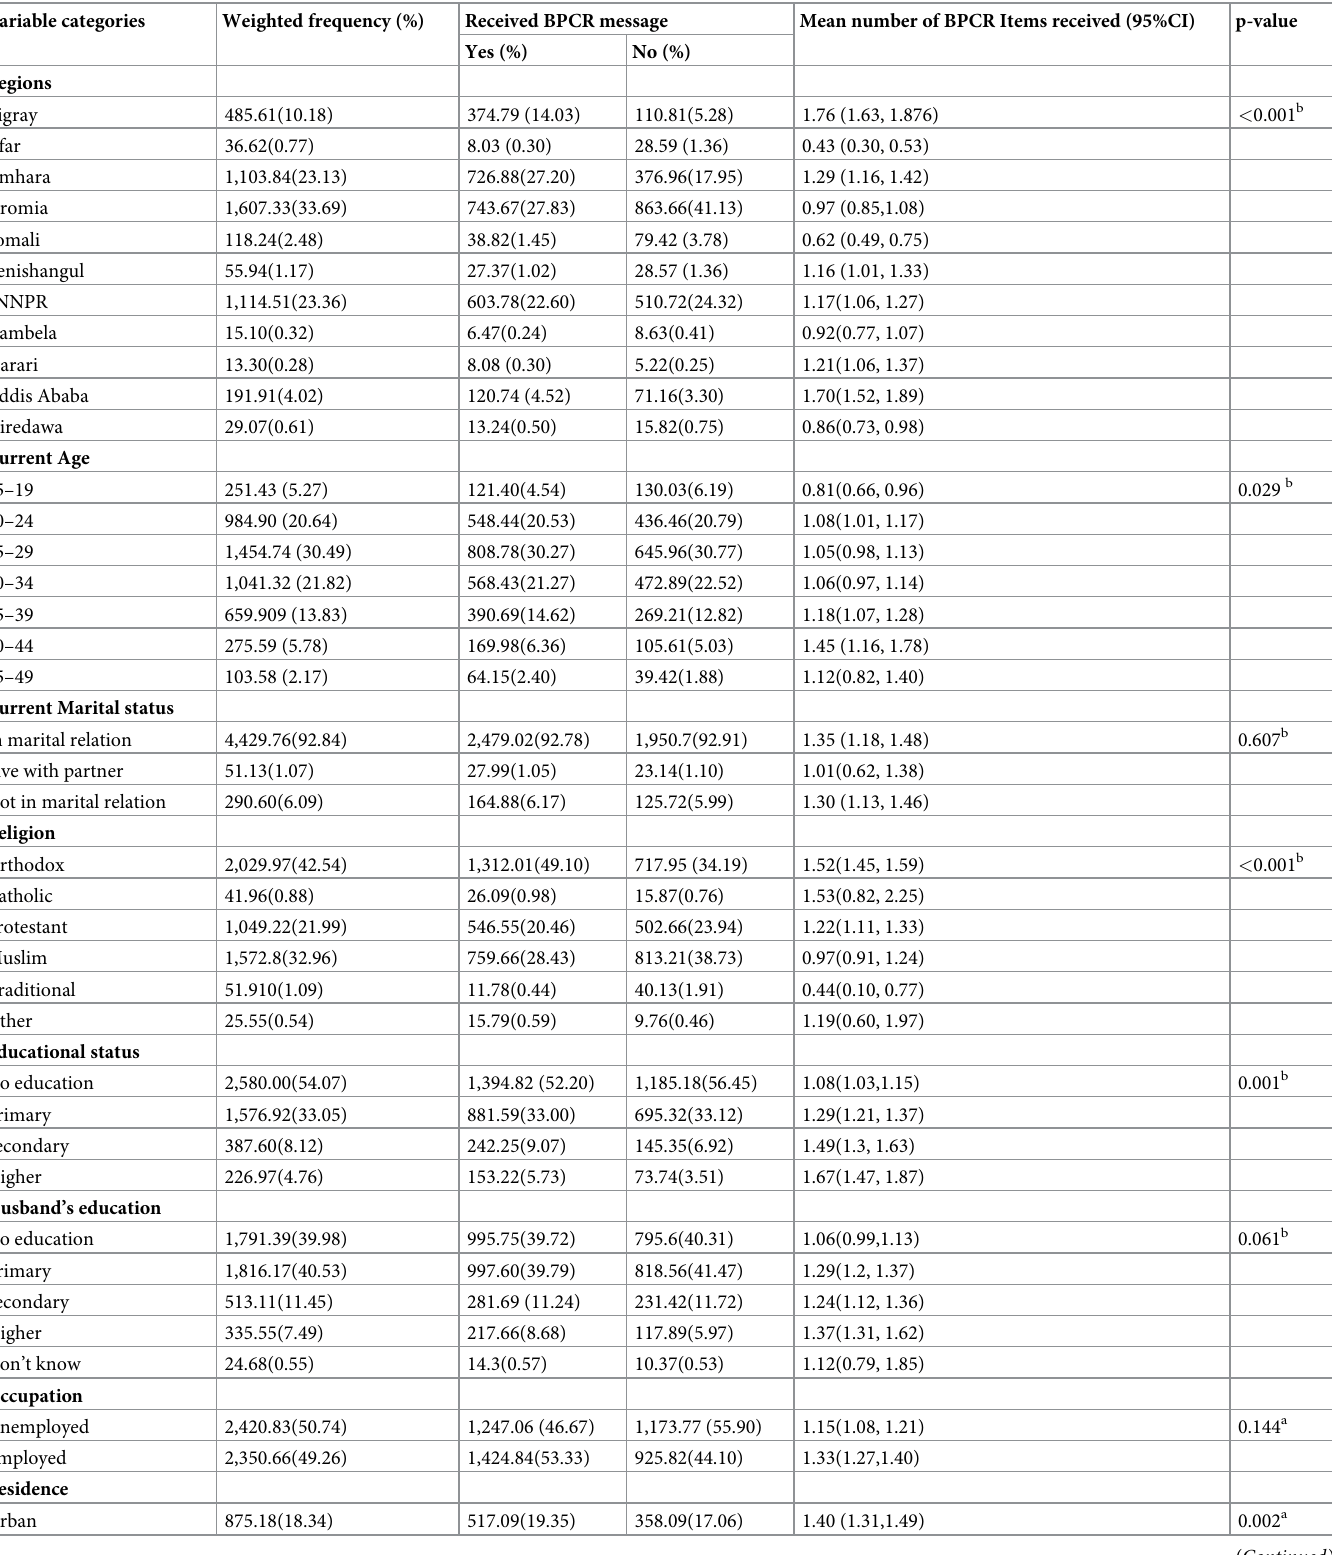
Table 1. Sociodemographic characteristics of women in the reproductive age across magnitude and mean number of BPCR messages in Ethiopia, 2016. Variable